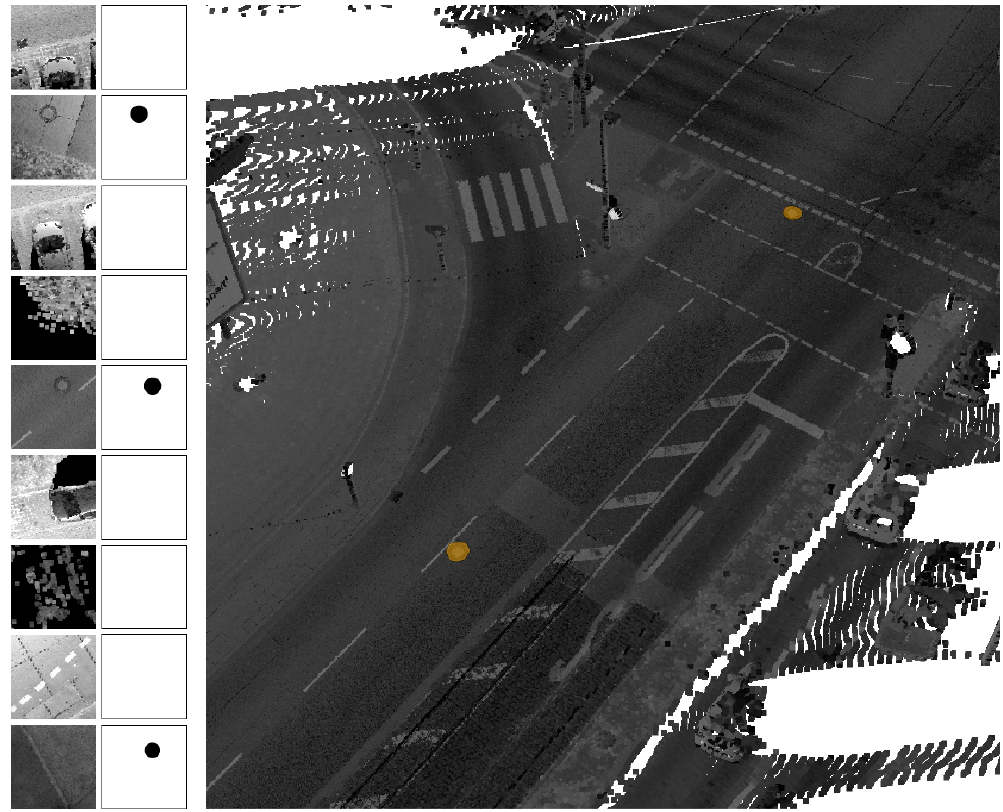
Figure 5. Left: Examples of rendered images and manually trained segmentation results for manhole covers. Right: Detected manhole covers projected back into the original point